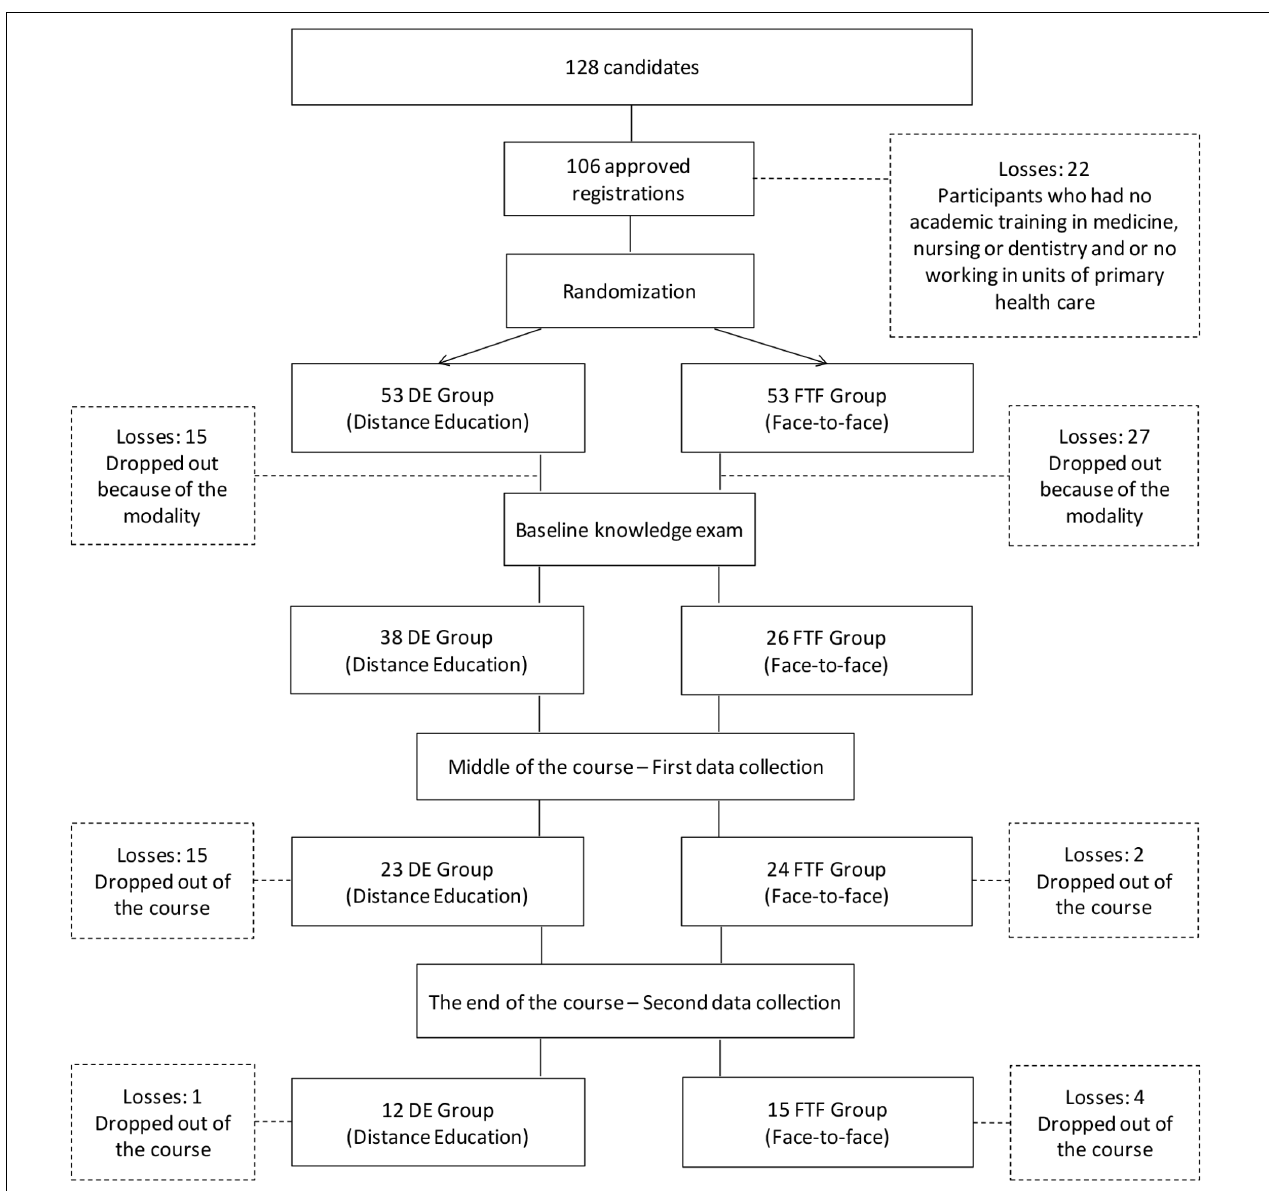
FIGURE 1 | Flow diagram of the participants in the research stages (elaboration by authors).